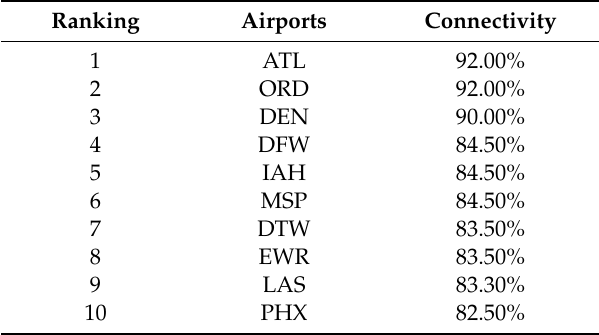
Table 4. Top 10 airports for